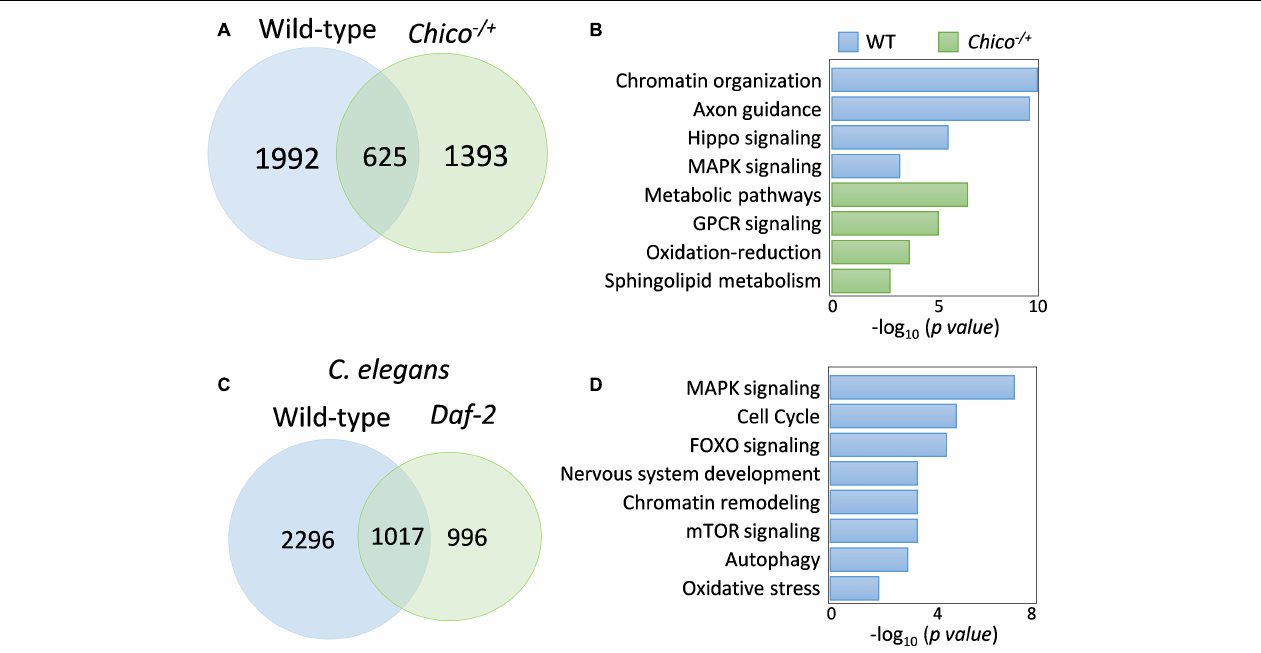
FIGURE 5 | FOXO binding differs between wild-type and insulin/IGF mutants. (A) Comparison of FOXO target genes between wild-type and chico mutants. (B) GO terms uniquely enriched in wild-type or chico mutants. (C) Daf-16-bound targets genes in wild-type C. elegans and Daf-2 mutants. (D) Shared pathways targeted by both fly FOXO and worm Daf-16 in wild-type animals. Enriched C. elegans GO terms are